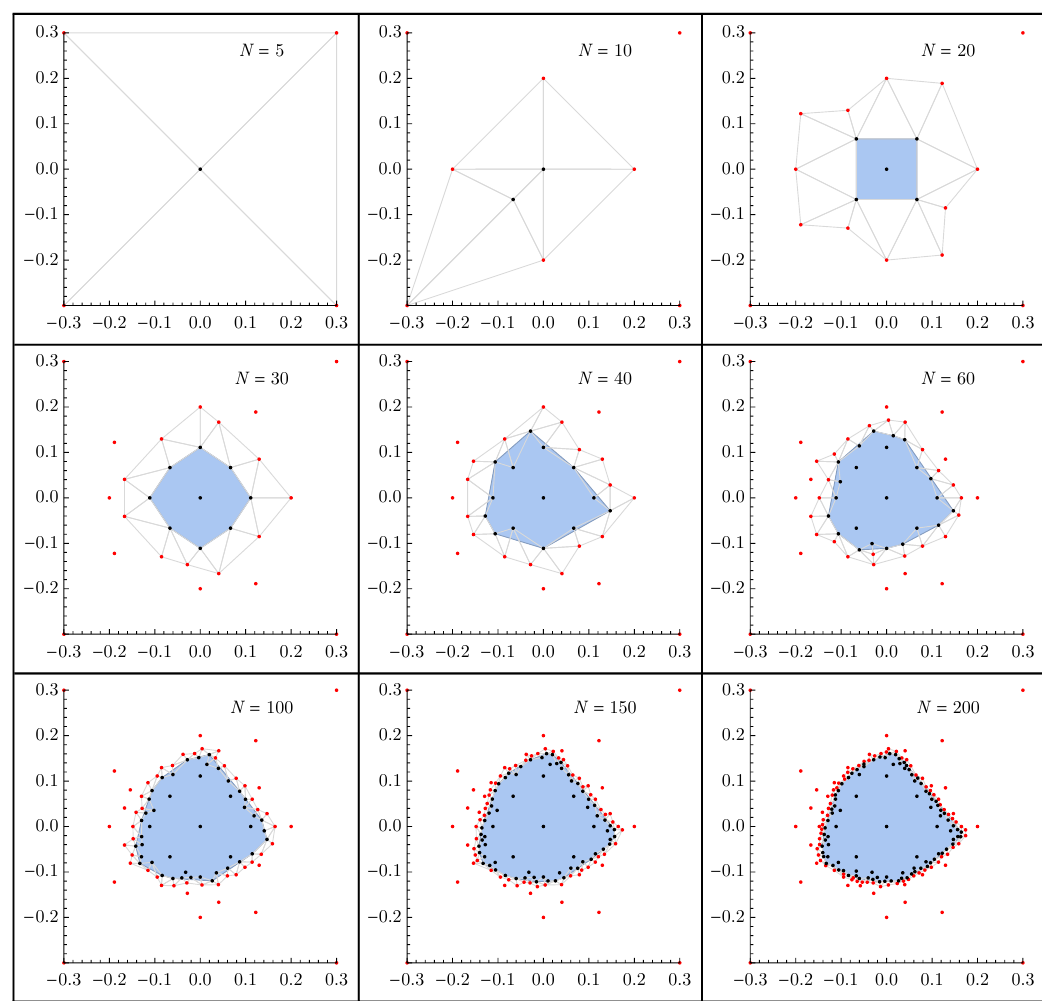
Figure 7 . A series of images show intermediate states of the Delaunay triangulation algorithm for 3d Ising (cid:27) , (cid:15) mixed correlator bootstrap. The setup is same as the dark blue region of (cid:12)gure 3 in [5] except n max = 10 ((cid:3) = 19). We transformed the ((cid:1) (cid:27) ; (cid:1) (cid:15) ) space such that the 3d Ising island is roughly spherical. The red points are disallowed, while black points are allowed. The blue region is the convex hull of the black points. The N in each plot is the total number of sampled